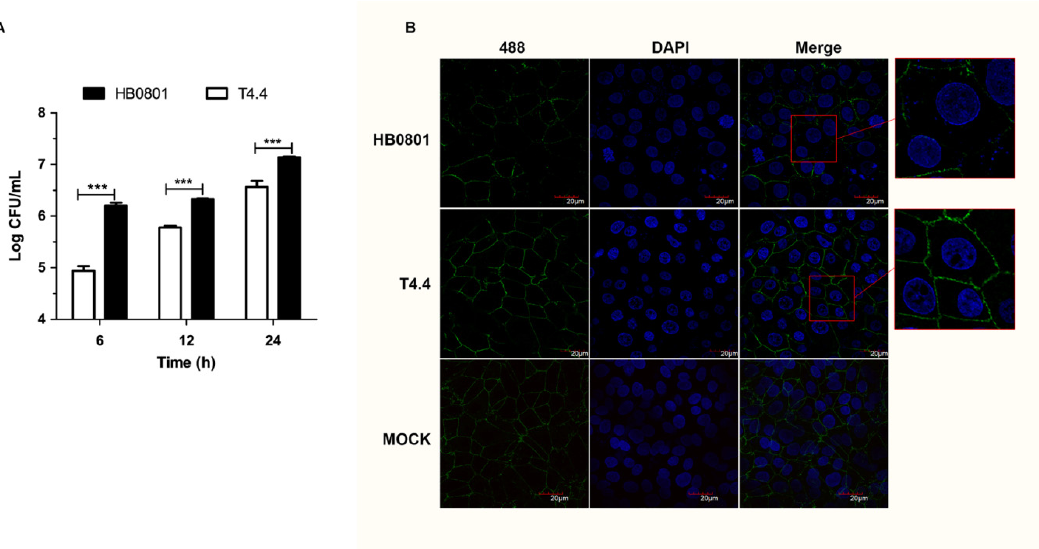
Figure 5. Translocation of Mbov_0503 knock-out mutant across MDBK epithelial cell monolayers. ( A ) MDBK cell monolayers grown on Transwell chambers were infected with Mbov_0503 knock-out mutant (T4.4) or the parental strain (HB0801) at the apical side, and mycoplasmas that translocated to the basal chamber were enumerated by counting CFU. ( B ) Structural integrity of the tight junctions in MDBK cell monolayers infected with the Mbov_0503 knock-out mutant (T4.4) or the parental strain (HB0801). The tight junctions were visualized by laser scanning confocal microscopy using anti-ZO-1 and Alexia 488-conjugated anti-IgG antibodies (Green). The nuclei were labeled with DAPI (Blue). MOCK-infected MDBK cell monolayers were used as a negative control (MOCK). Images in red boxes were magnified for 2.5 times. P values are indicated by asterisks (*** p < 0.001).